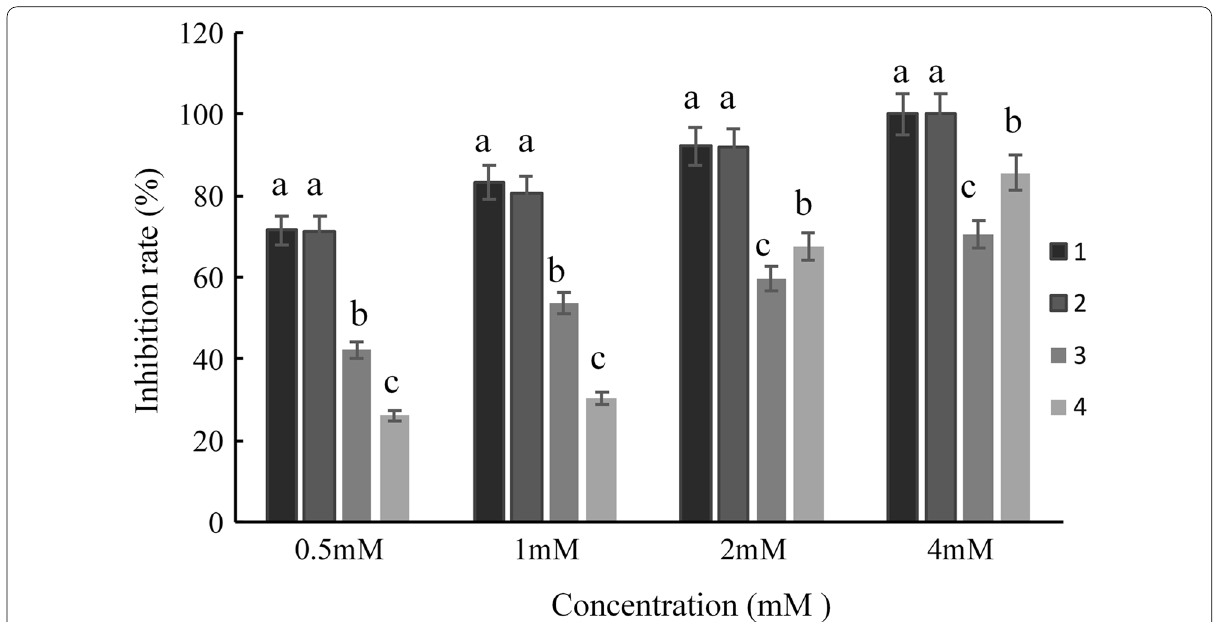
Fig. 5 Effect of the compounds 1 – 4 on the percent inhibition of O. aegyptiaca seeds germination. The different lowercase letters represented significant difference at 0.05